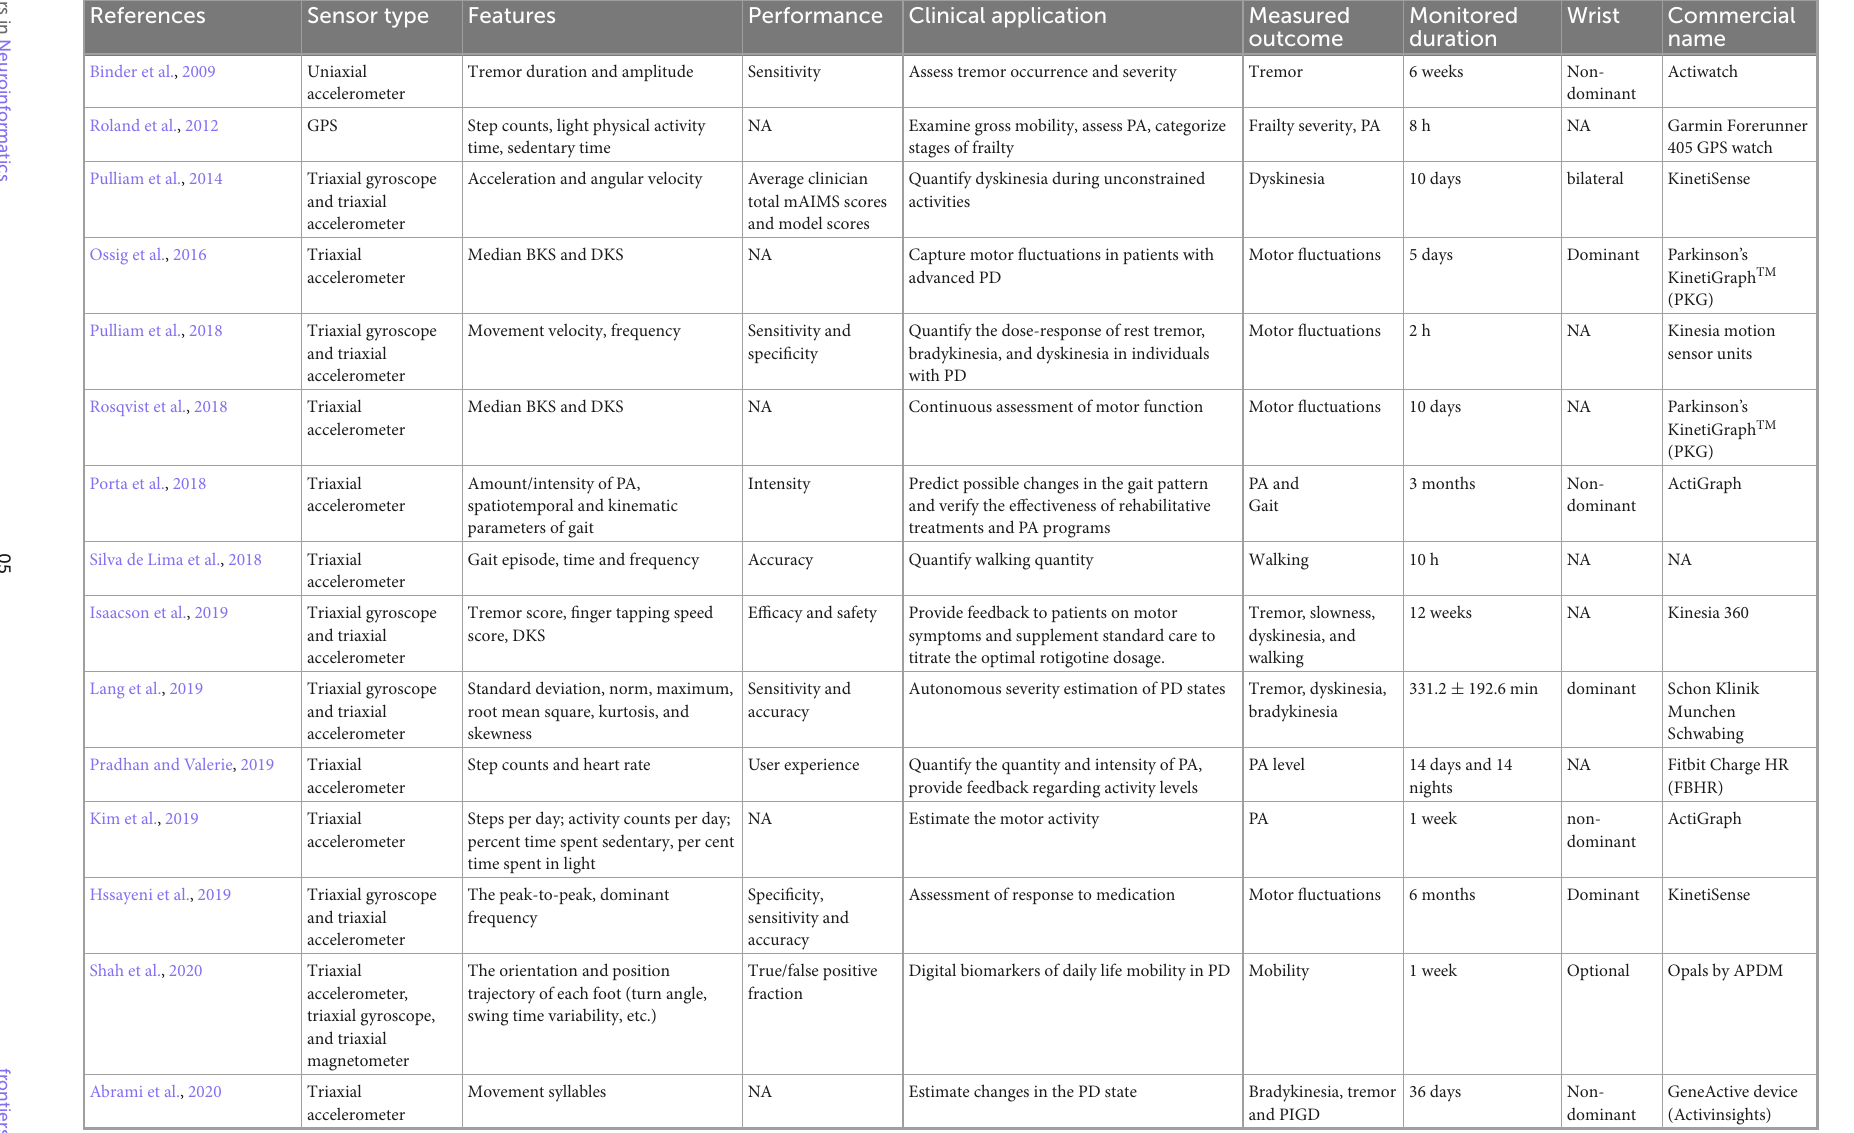
TABLE 2 Articles about wrist-worn commercial devices for telemonitoring motor signs in PD and related